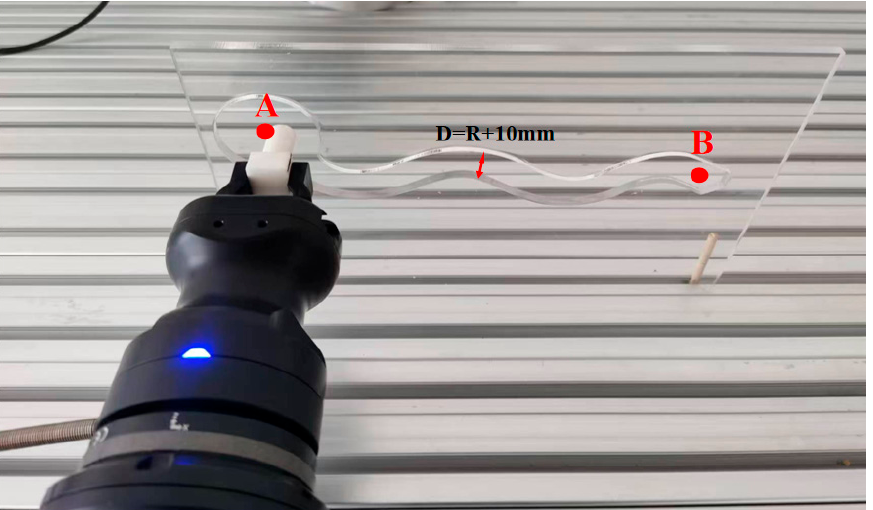
Figure 14. The setup of the challenging task.